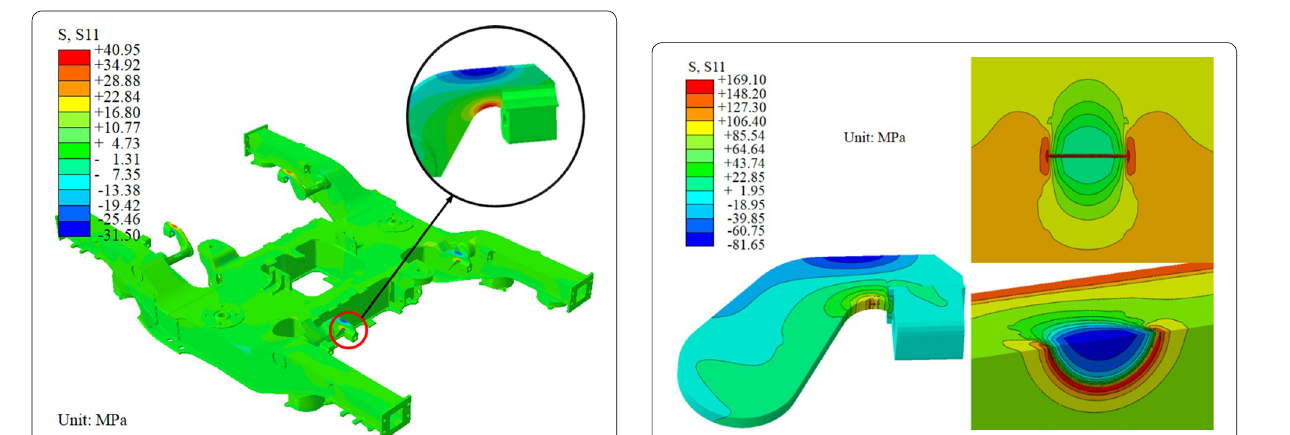
Figure 7 Result of brake unit bracket with a 1 mm crack under braking load